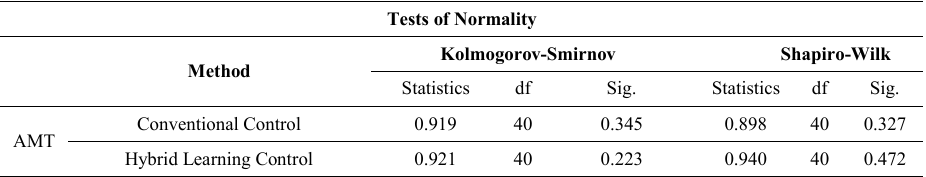
Table 6. Normality Test Results Based on the learning model factors.